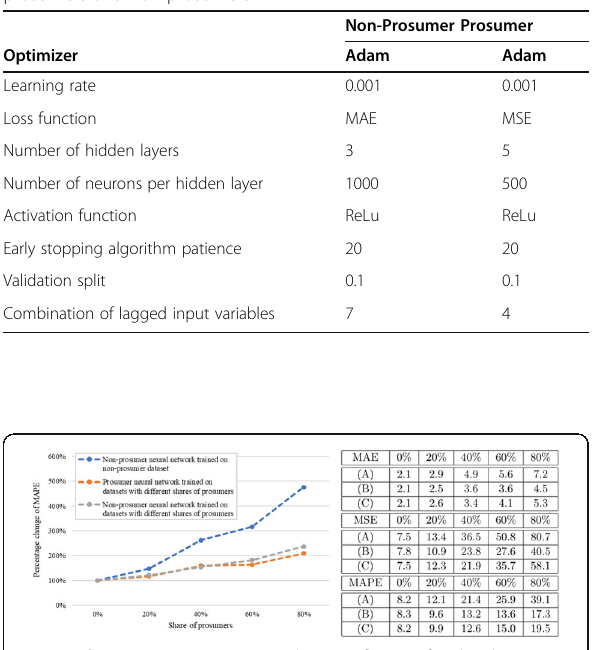
Fig. 1 (abstract P5). Percentage change of MAPE for the three neural networks setups tested with datasets with different shares